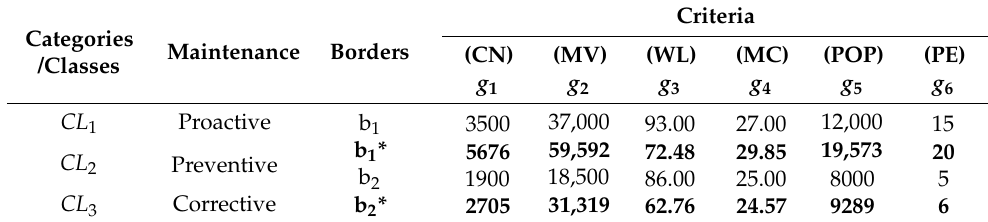
Table 9. Final Boundaries adopted defined by FCM Procedure 1.